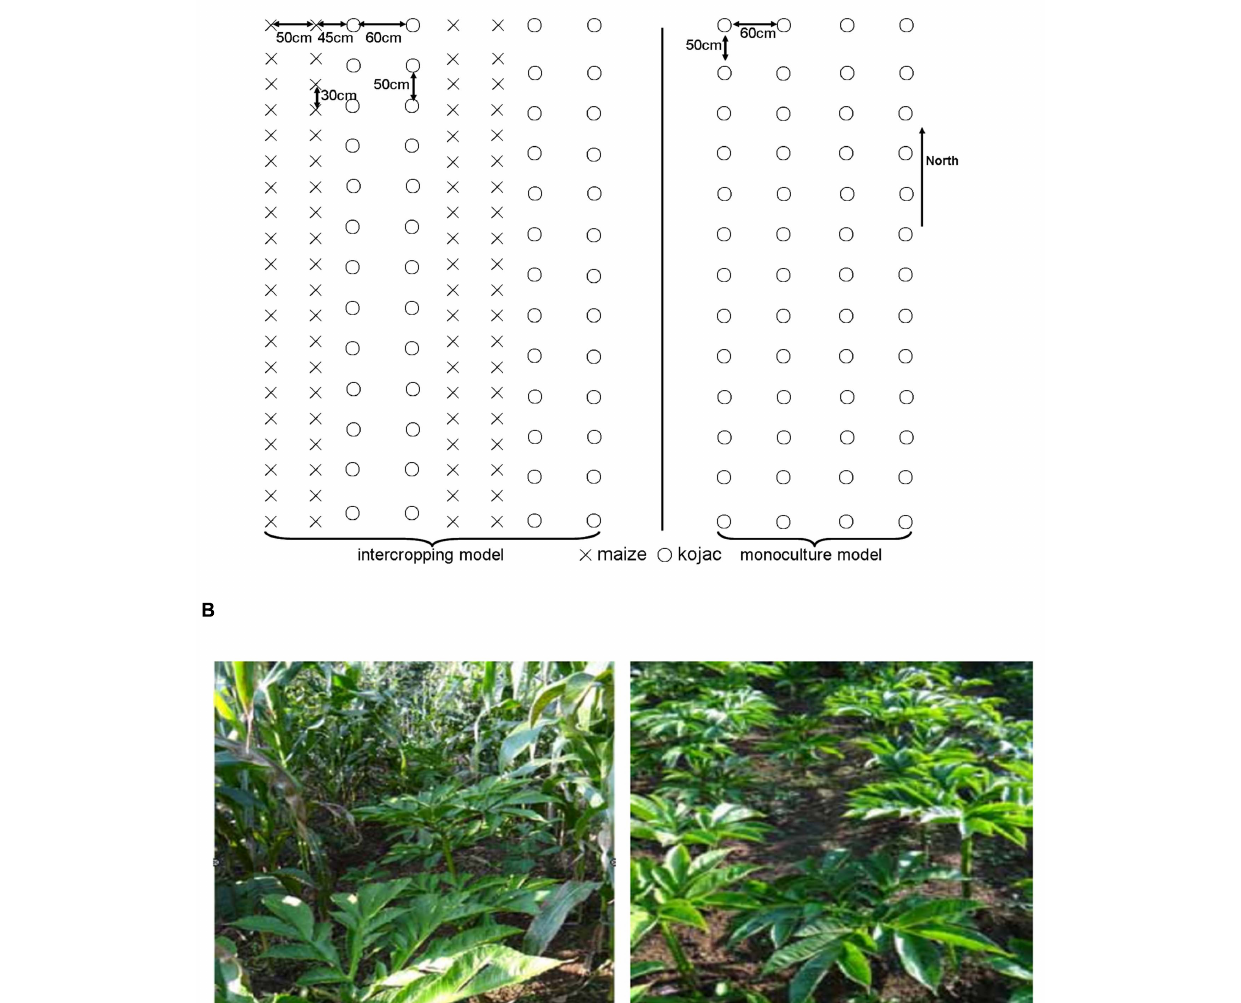
leaves than in the monoculture leaves; however, a reverse trend was observed for non-photochemical quenching (NPQ) ( Figures 4A–D